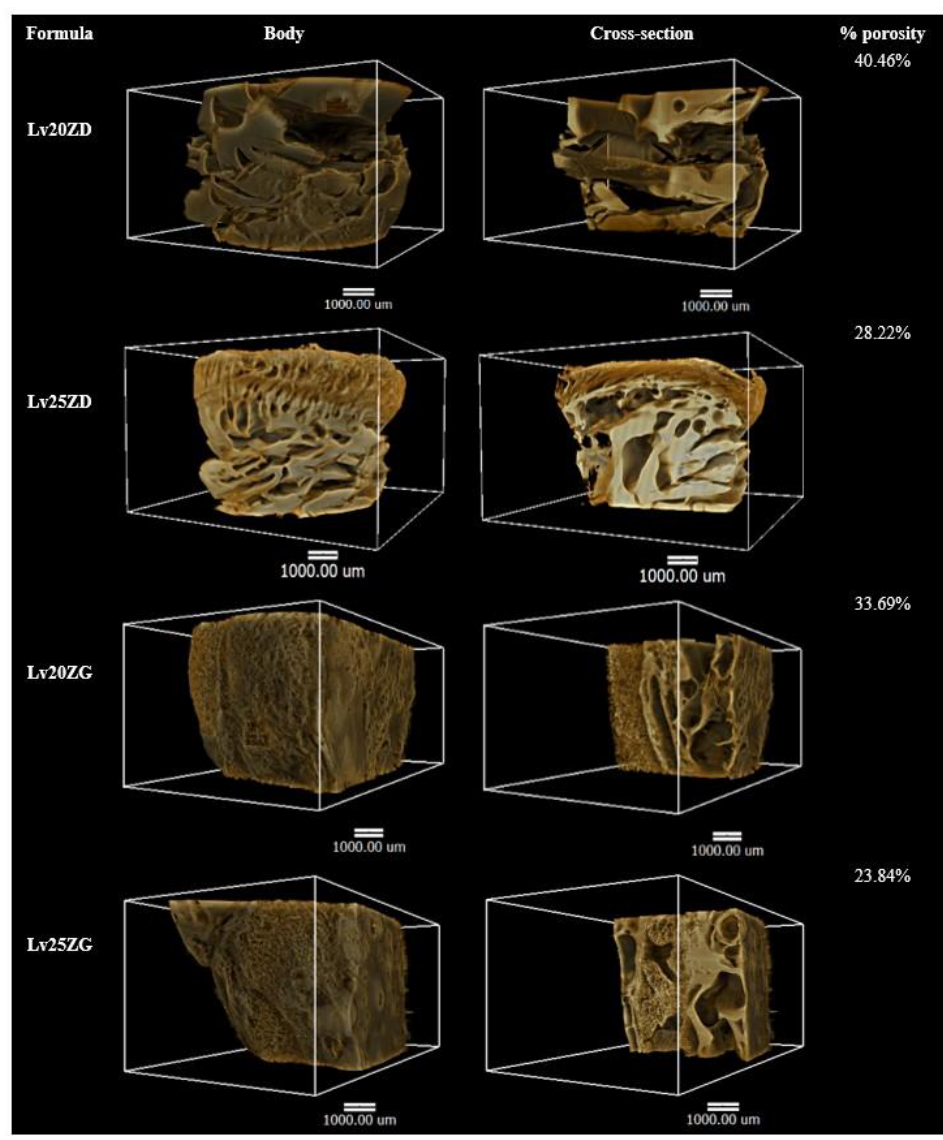
Figure 7. X-ray tomography image and % porosity using X-ray tomography of the freeze-dried Lv- loaded zein-based